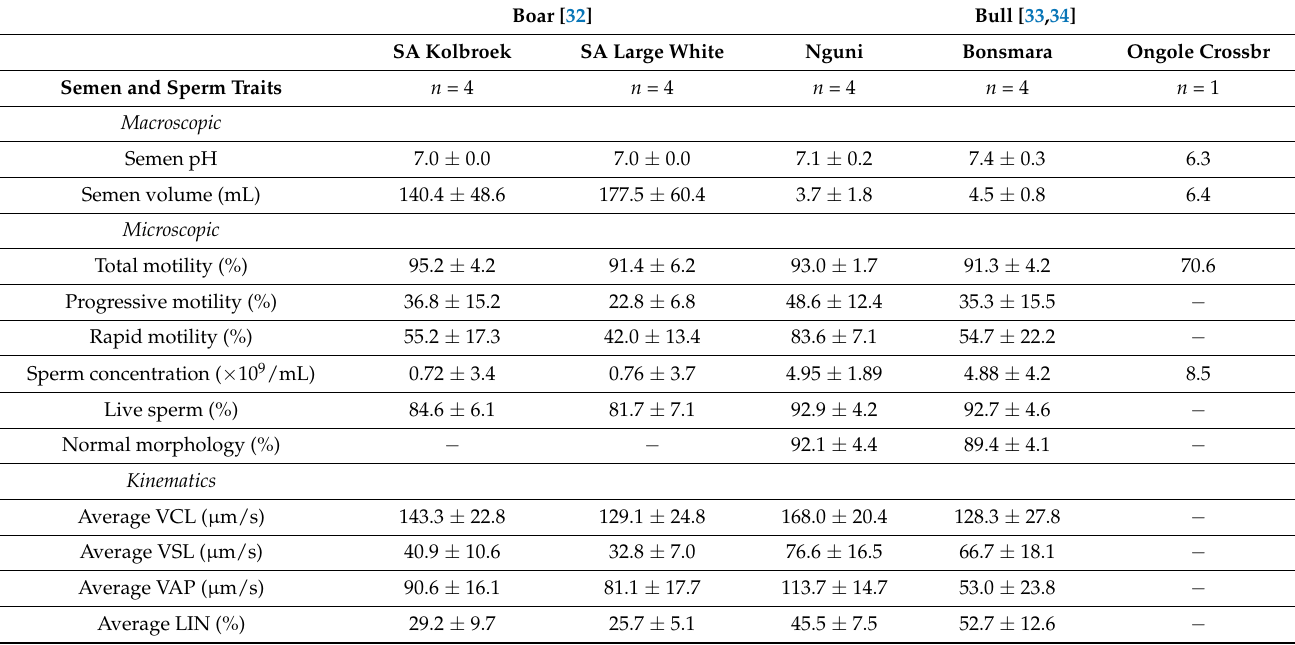
Table 4. Comparison of semen and sperm characteristics of indigenous and crossbred pigs and